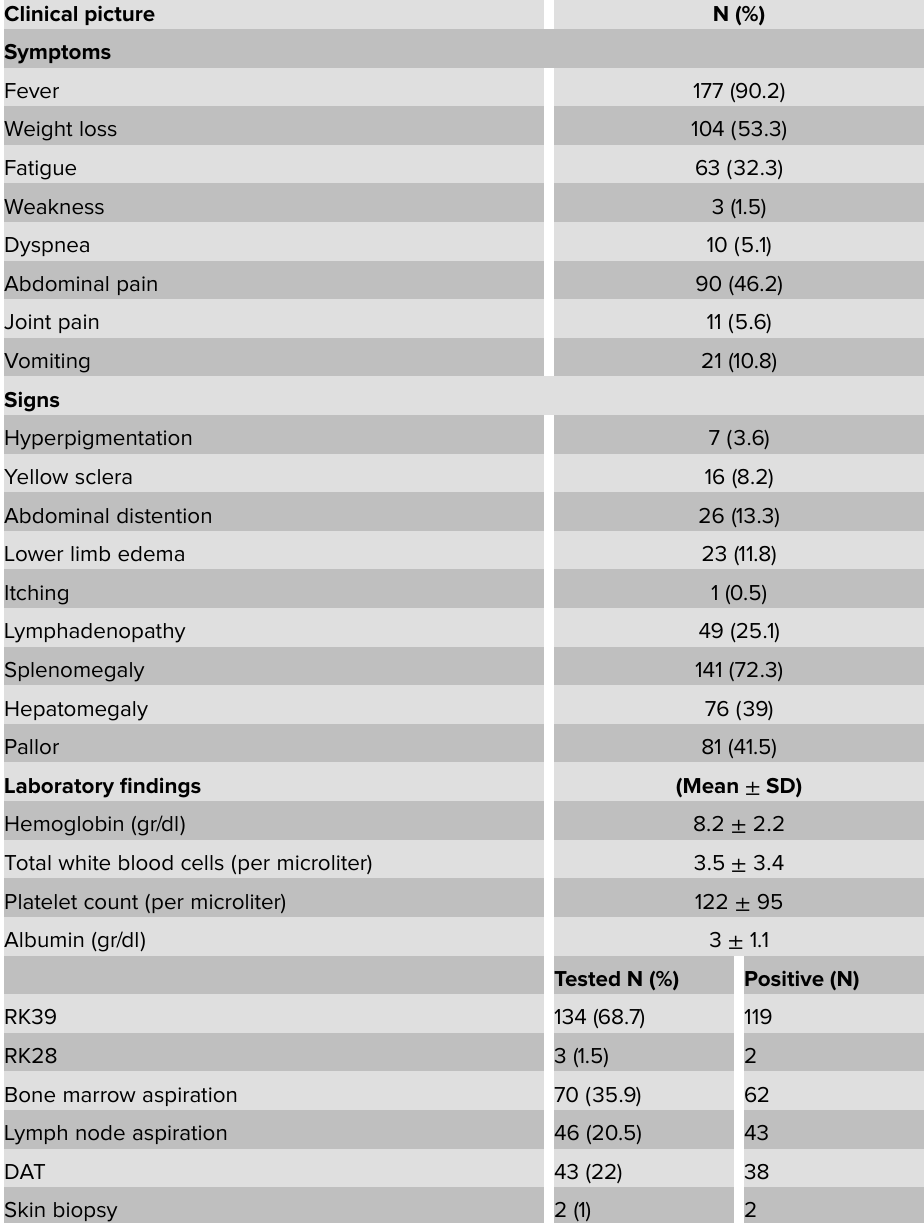
Table 3: Clinical manifestations often observed in patients with VL admitted to the